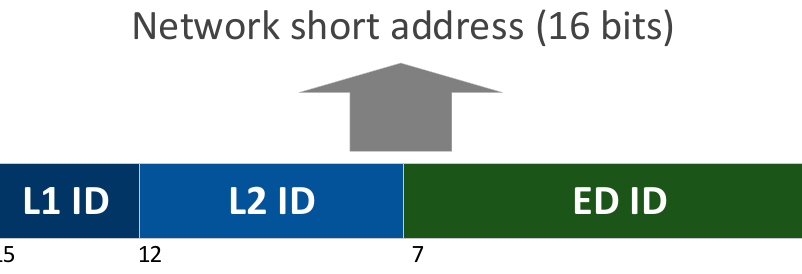
Figure 5. Addressing scheme of the combined network.